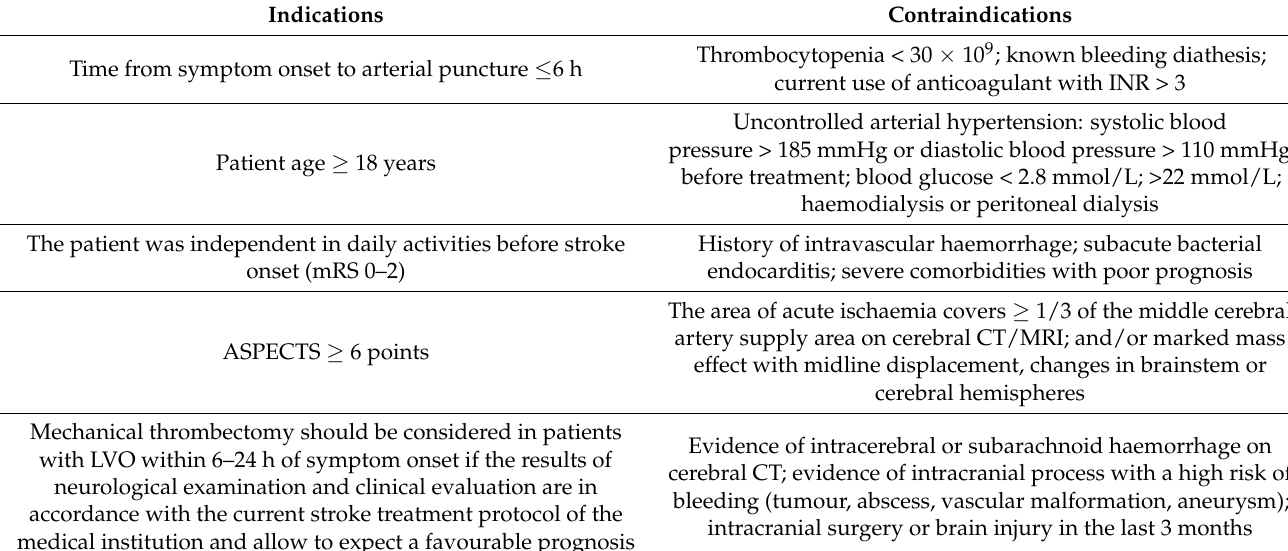
Table 1. Indications and contraindications for mechanical thrombectomy [45].